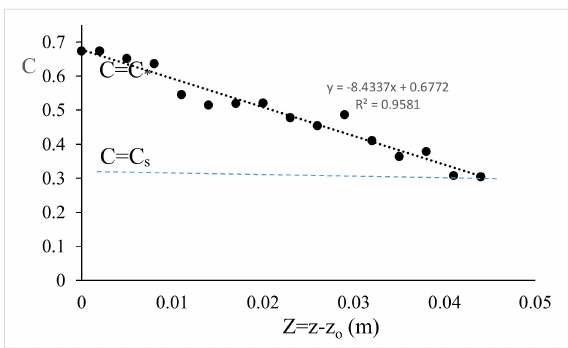
Figure 5. Measured grain concentrations C and interpolating law ( Z indicates the direction orthogonal to the bed with an origin at the upper level of the static